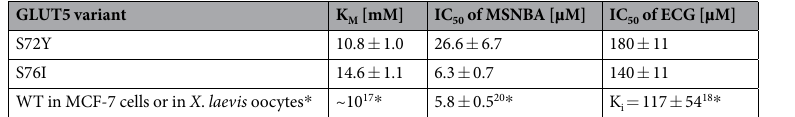
Table 2. GLUT5 transport kinetics and inhibition in hxt 0 yeast cells (see also Fig. 4). * Values from References indicated in